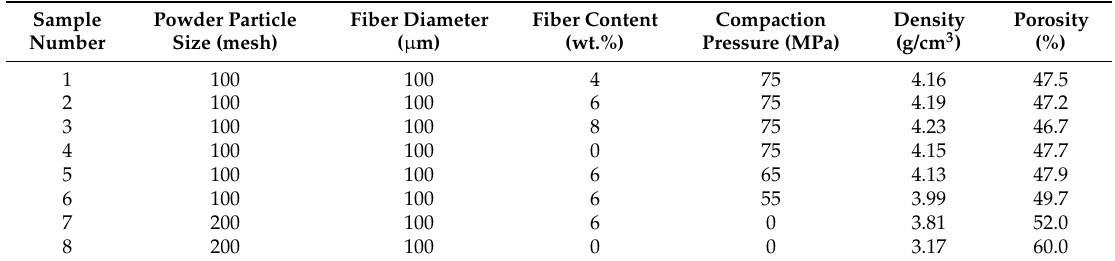
Table 1. The P/M samples and their parameters.